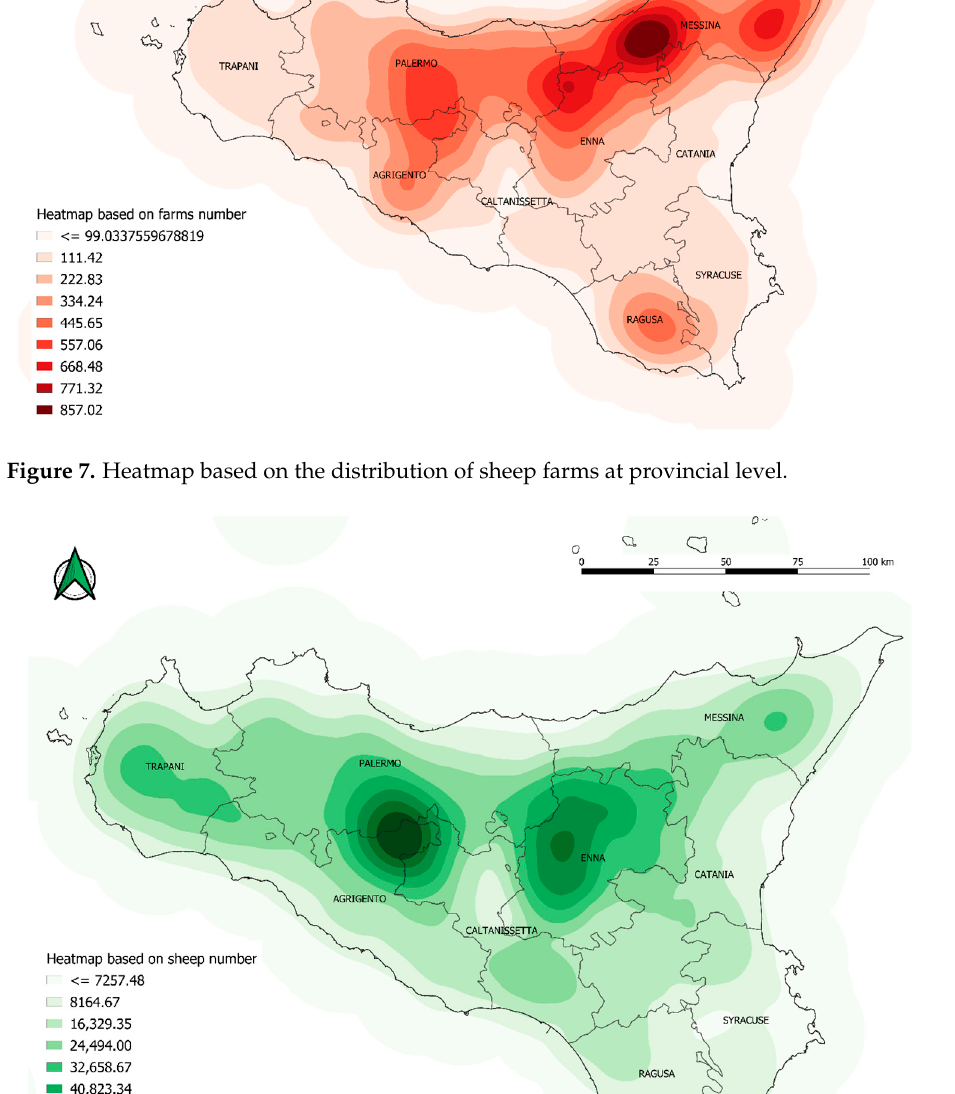
Figure 8. Heatmap based on the distribution of sheep number at provincial level.